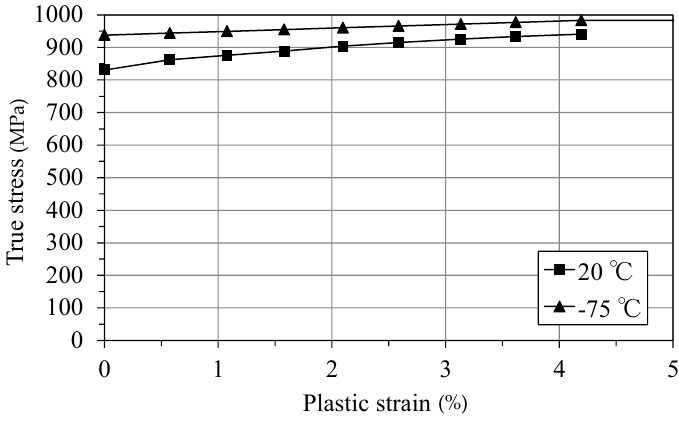
Figure 4. True stress–plastic strain curve for each temperature for HT780.